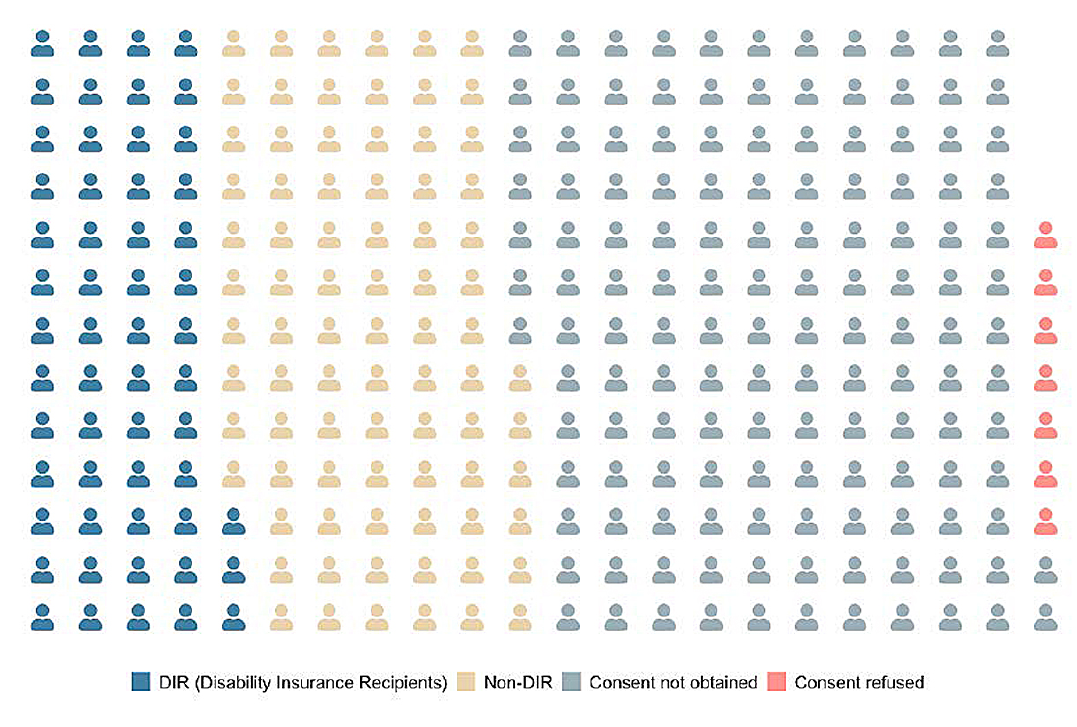
Table 1: Baseline and clinical characteristics from the Swiss Transplant Cohort Study stratified by disability insurance recipients (DIR) and non-recipients (non-DIR). Recipient age (years), median (IQR) 48 (41–57) 48 (37–54) Gender, n (%) Female 23 (41.8%) 27 (33.3%) Donor type, n (%) Previous transplantation, n (%) Underlying kidney disease, n